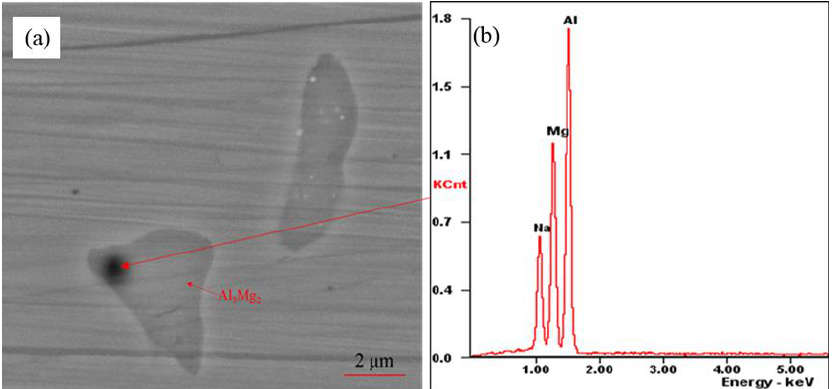
Figure 7. ( a ) SEM shows the Na and Al 3 Mg 2 (β) phase ; ( b ) the EDS result corresponding to the arrow. 254